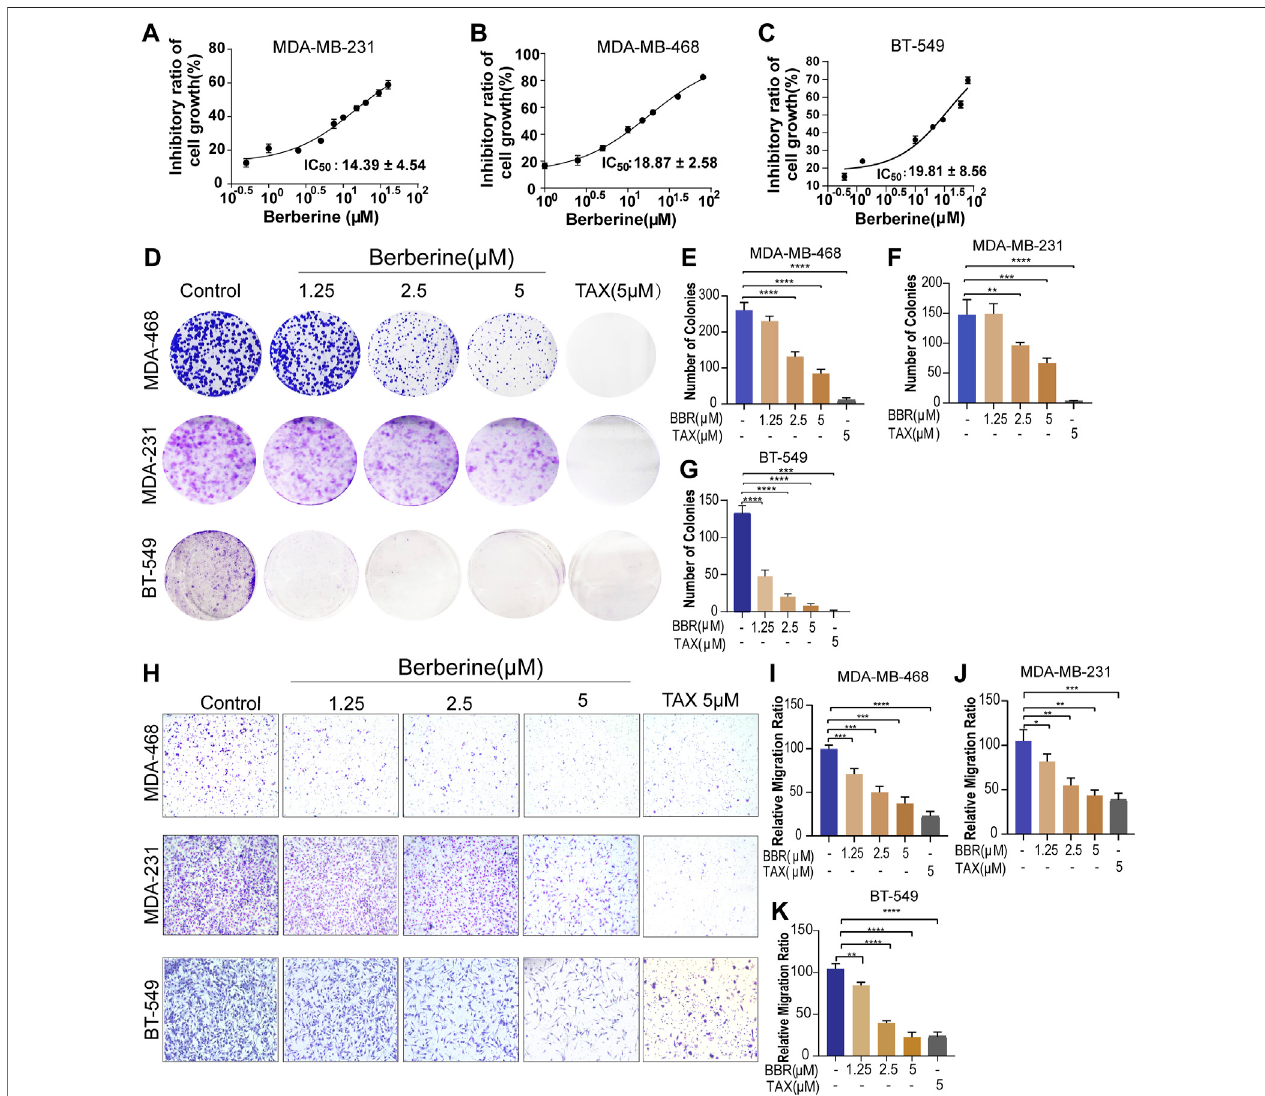
FIGURE 1 | Berberine inhibits the proliferation and migration of TNBC cells. (A – C) Viability of the TNBC cells treated with berberine for 72 h was analyzed by the MTTassay.Thecellviabilitydatawerenormalizedbycomparingtocontrolcells,andGraphPadPrismeightSoftwarewasusedtoanalyzethedata. (D) Antigrowtheffect ofberberineontheTNBCcellswasdeterminedbycolonyformation.TheTNBCcellsweretreatedwithberberineorTAXfor3 days,thenremovedthedrugsandcultured the cells in a drug-free medium for 6 – 8 days. Finally, crystal violet was used to stain the colonies. (E – G) The percentage of colonies was calculated by GraphPad PrismeightSoftware.TAX(5 μ M)wasusedasthepositivecontrol. (H – K) Representativeimagesandquanti fi cationofmigrationoftheberberine-treatedTNBCcells.TAX was used as a positive control drug. 10 × scale bars, 200 μ m. Error bars were means ± SD. p < 0.05, p < 0.01, p < 0.0001 vs. control.